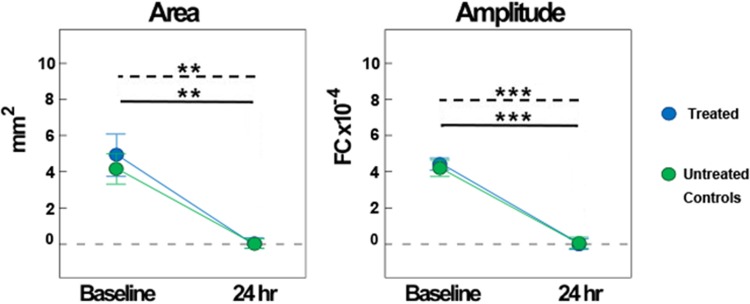
Treated and untreated hypertensive subjects show a strong reduction in the whisker functional representation (WFR) 24 hours after pMCAO.Quantification of the area (left) and amplitude (right) of the WFR at both baseline and 24 hours for treated and untreated subjects. Treated (n = 7) and untreated (n = 7) subjects showed a significant decrease in both parameters at 24 hours post-pMCAO compared to baseline (dashed and solid lines, respectively) (* = p ≤ 0.05, ** = p ≤ 0.01, *** = p ≤ 0.001).